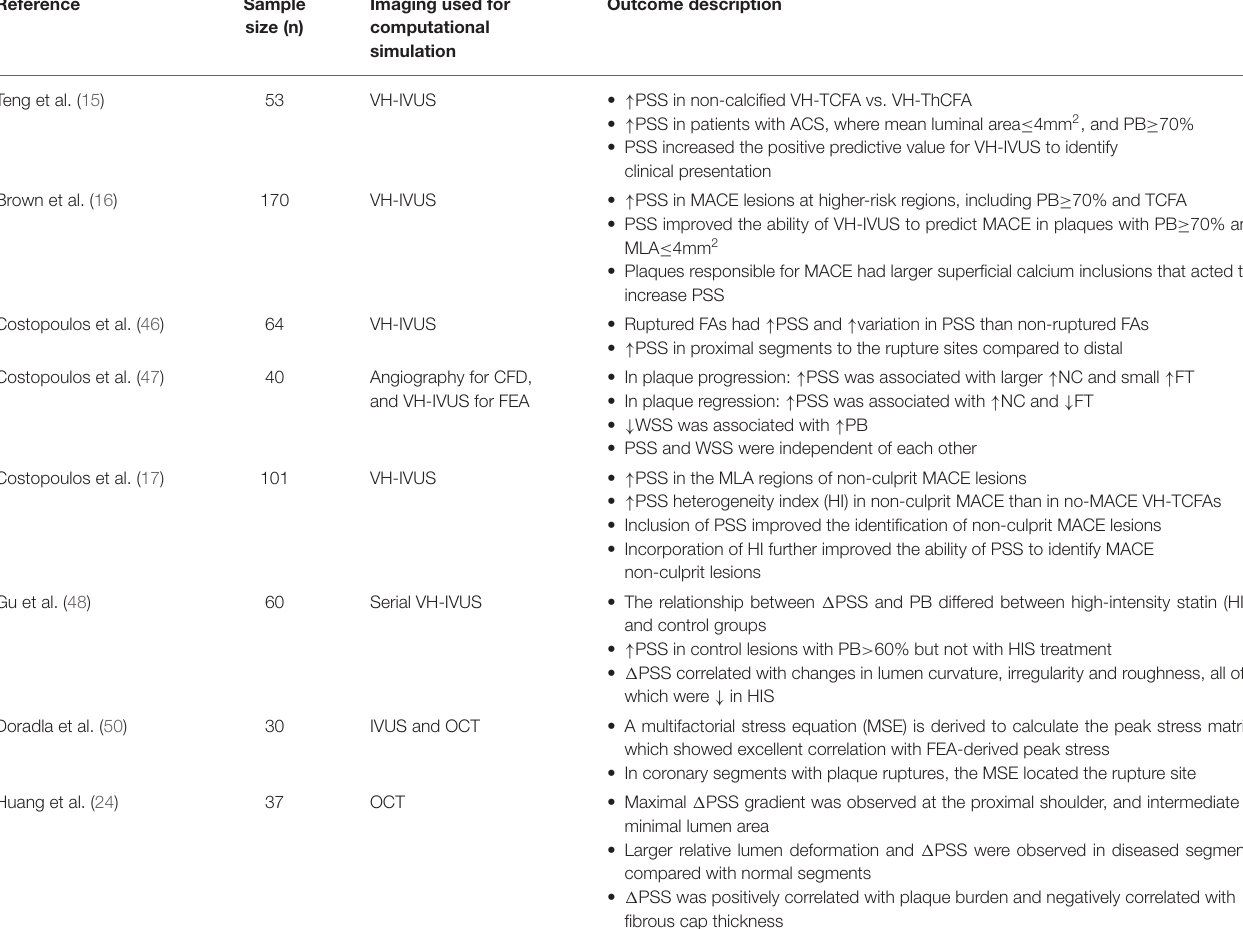
TABLE 1 | Recent clinical studies assessing the effect of PSS in coronary atherosclerosis.